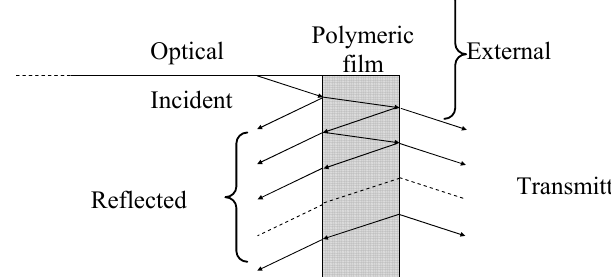
Figure 15. Schematic of the multiple beams interference in a F-P cavity formed by a thin layer of s-PS deposited on a cleaved fiber optic. Beams angles are exaggerated for explanatory